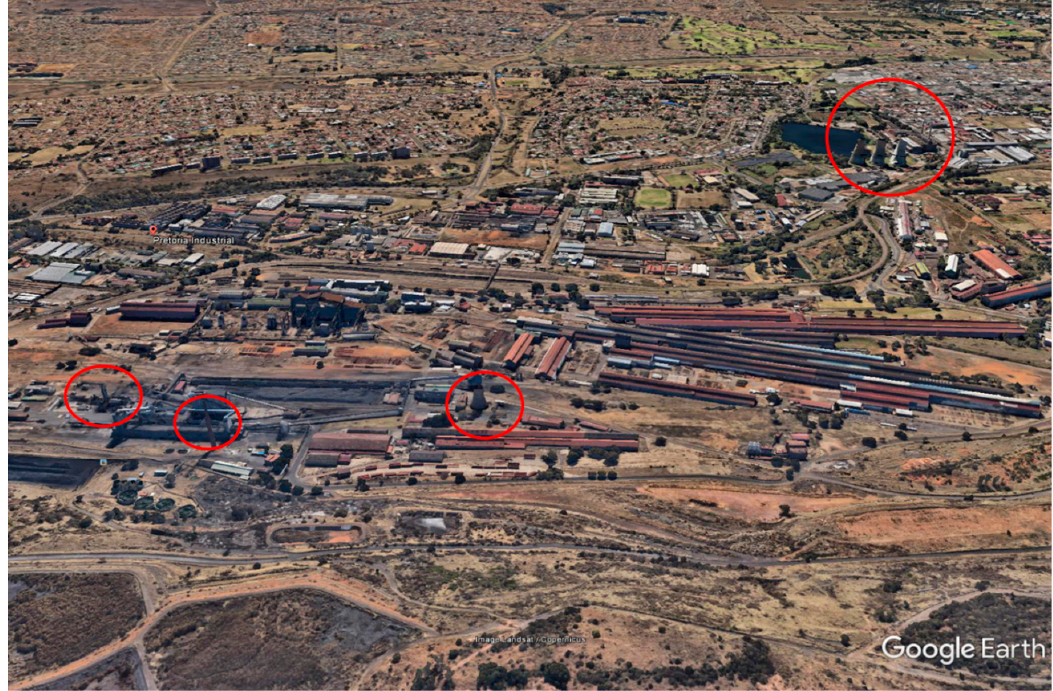
Figure 1. Google Earth image depicting Pretoria West industrial area. The red rings indicate some of the emission stacks in the study area.